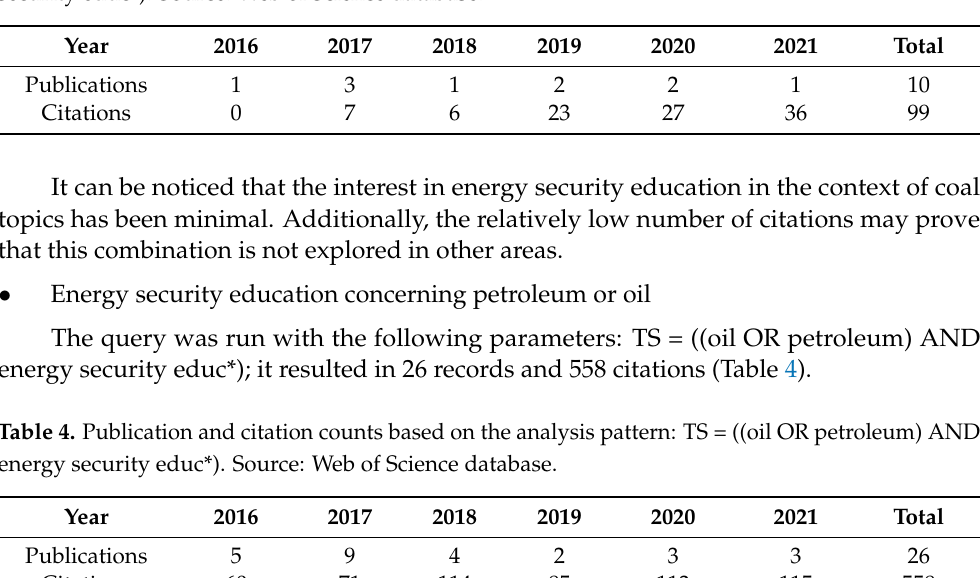
Table 3. Publication and citation counts based on the analysis pattern: TS = ((coal) AND energy security educ*). Source: Web of Science database.